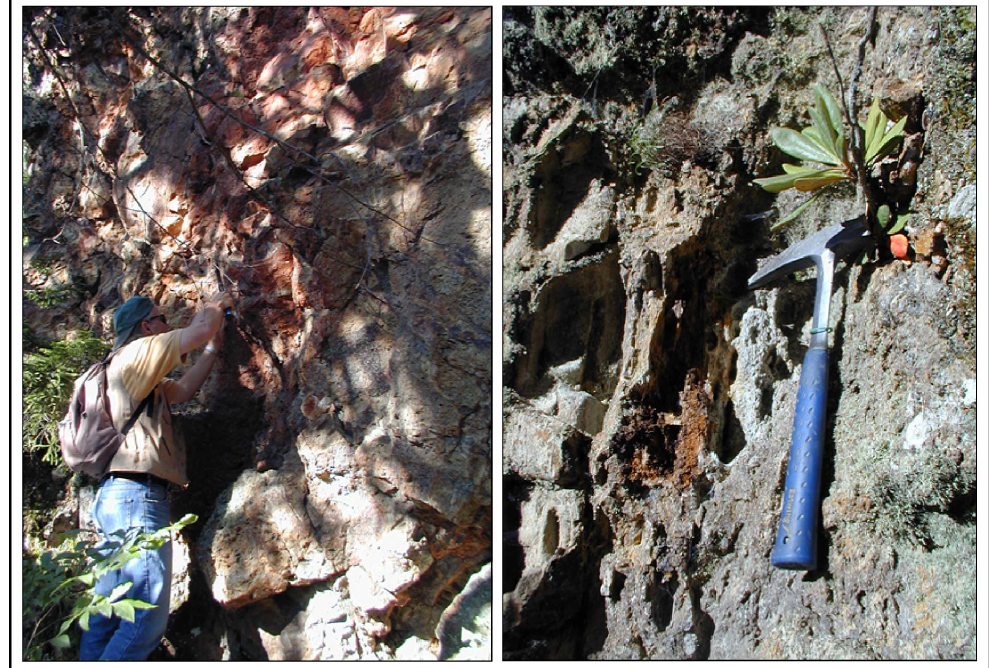
Figure 7. Close-up field view of gossan zone at Cerattepe VMSD,